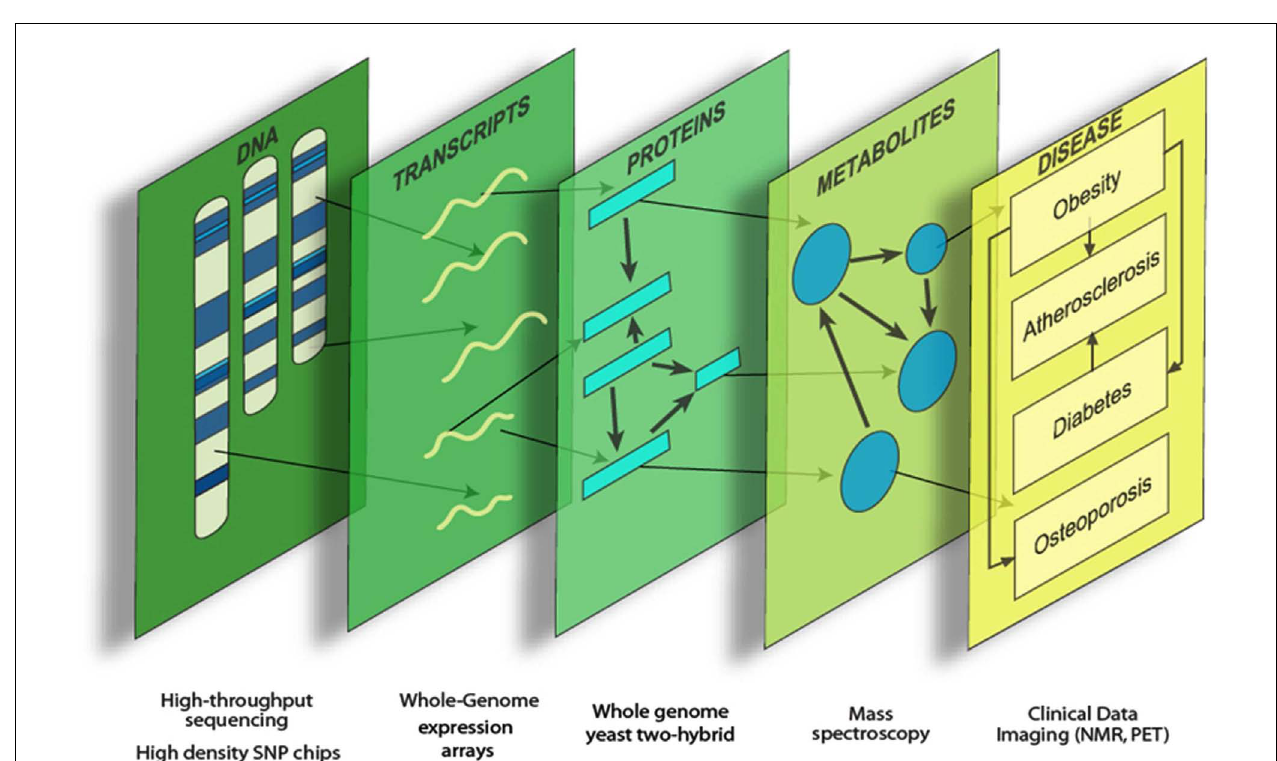
FIGURE 1 | Systems genetics analysis . Systems genetics integrates genetic variation, intermediate phenotypes, and clinical traits to map loci and model biological networks underlying the intermediate phenotypes, which are subsequently related to the more complex clinical traits.